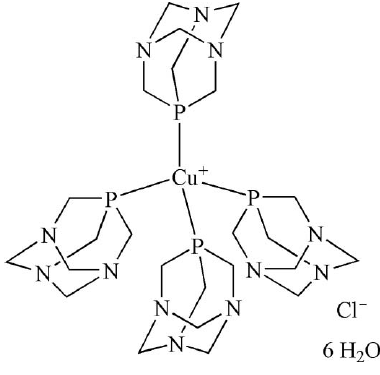
Absorption correction: multi-scan ( SADABS ; Sheldrick, 2003)